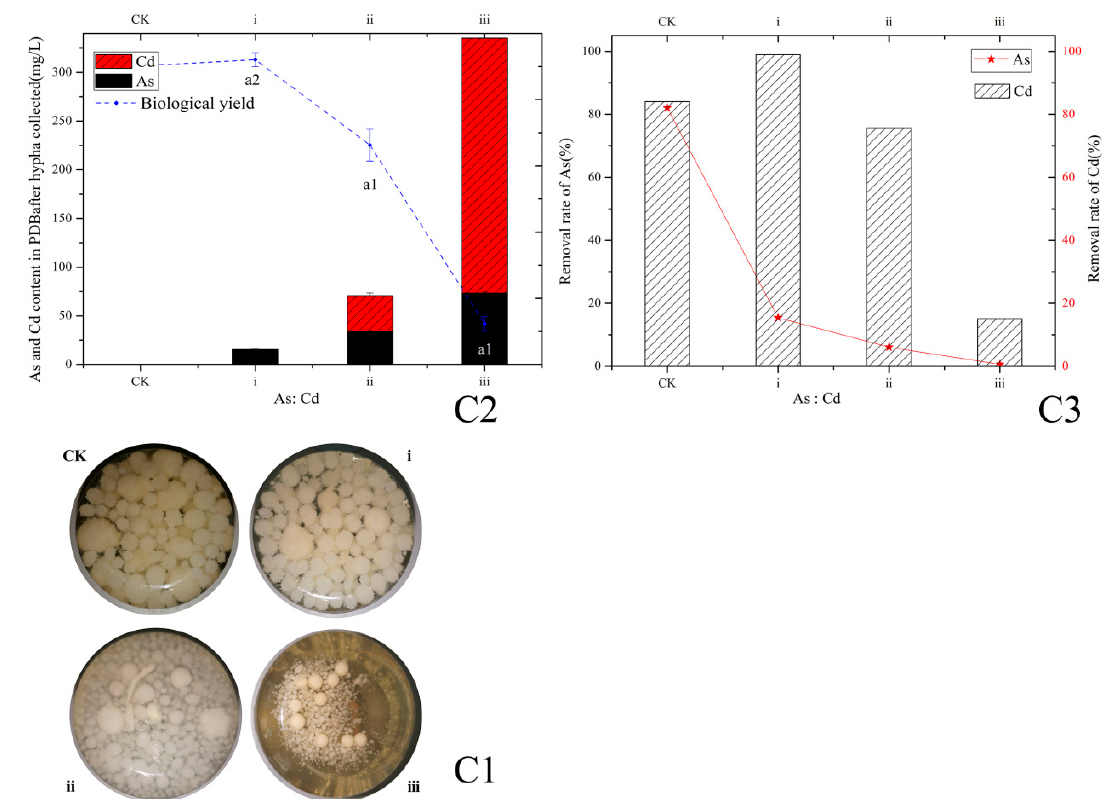
Figure 2. Simulation application in decontamination of liquid containing As(III) and Cd(II) by the hypha of P. pulmonarius MT. ( C1 ) Mycelia growth under Cd and As stress; ( C2 ) Cd&As content in PDB and the biological yield of mycelia under Cd &As stress; ( C3 ) Removal rates of Cd and As. CK: Untreated PDB medium; (i) PDB with 20 mg/L of As and 80 mg/L of Cd; (ii) PDB with 40 mg/L of As and 160 mg/L of Cd; (iii) PDB with 80 mg/L of As and 320 mg/L of Cd; a1: p < 0.05; a2: p >